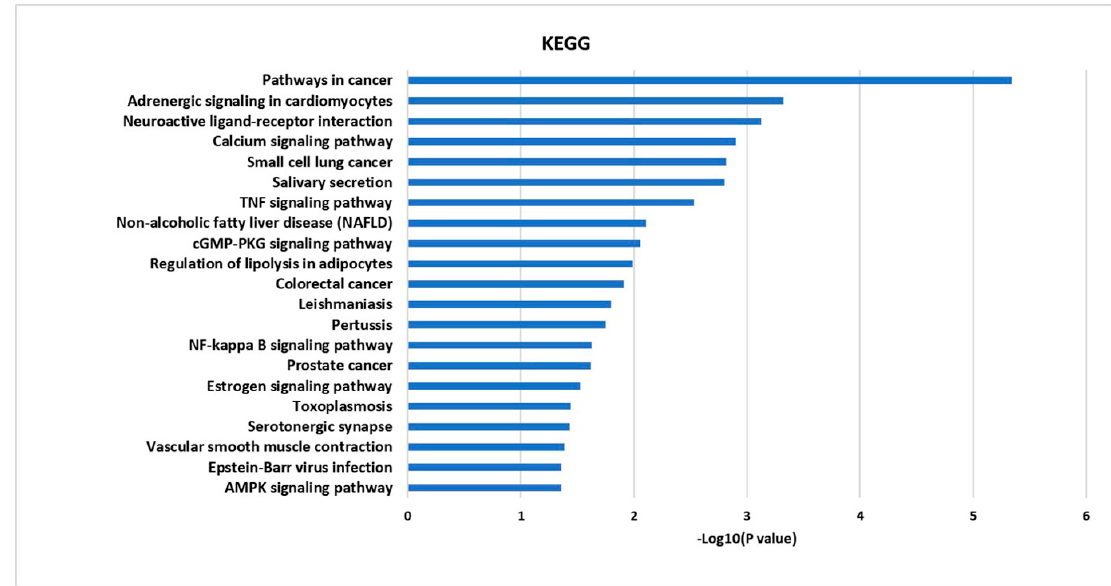
Figure 3. The KEGG pathway enrichment analysis for 21 targets.